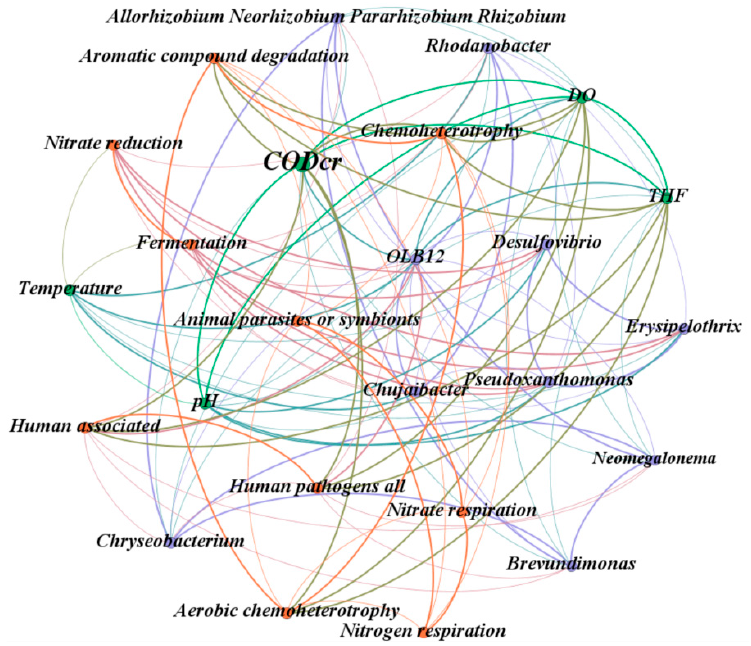
Figure 7. Network analysis diagram of microorganisms and metabolic pathways.